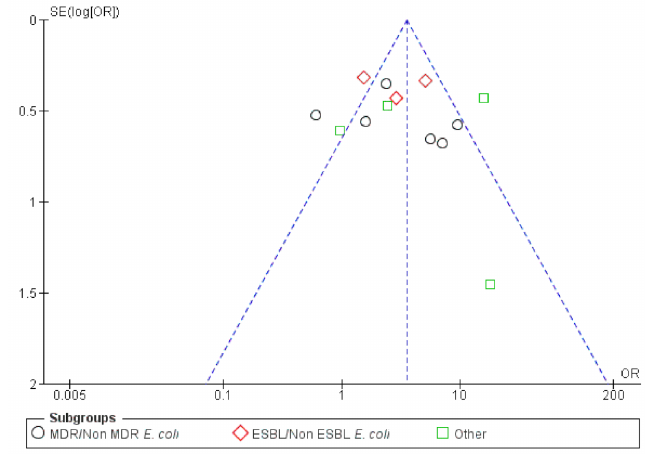
Figure 10. Funnel plot of standard error by OR (Odds ratio)—UTIs (Urinary Tract Infections) resistance.